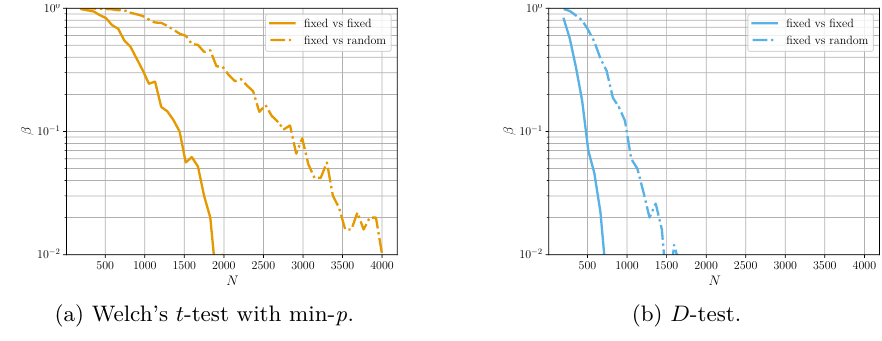
Figure 14: Detection rate for various input